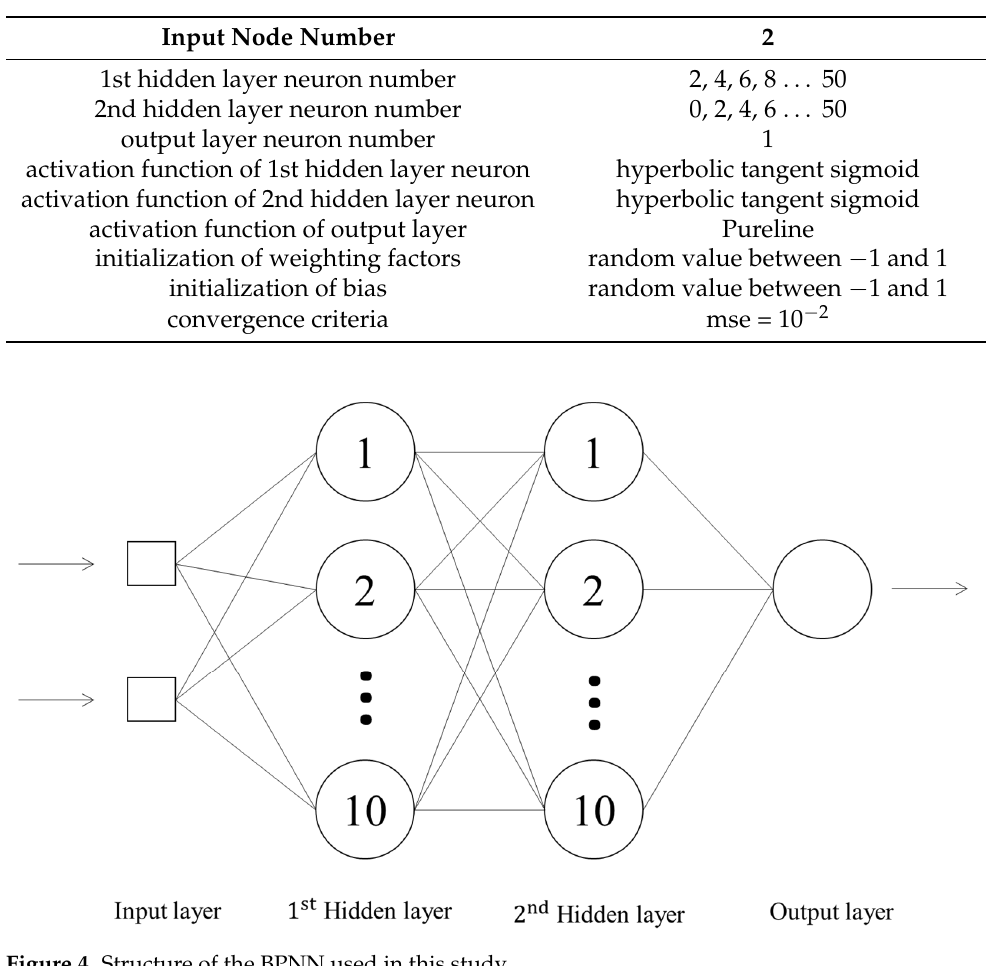
Figure 4. Structure of the BPNN used in this study.